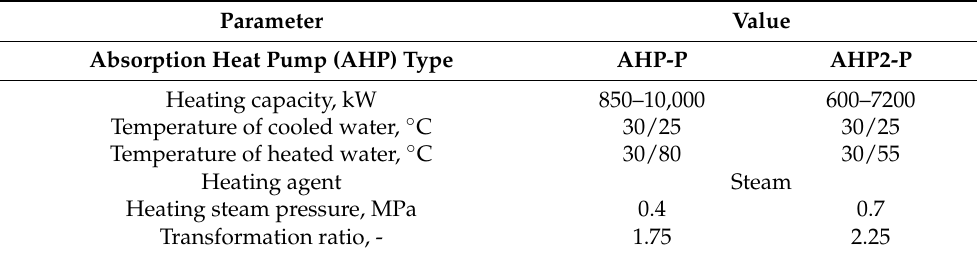
Table 1. Technical characteristics of heat pumps of “Teplosibmash”